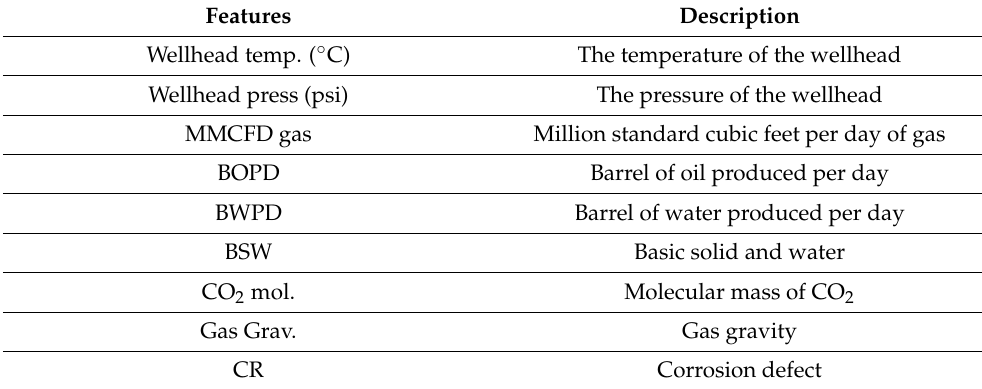
Table 1. Features Table 1. Features description.